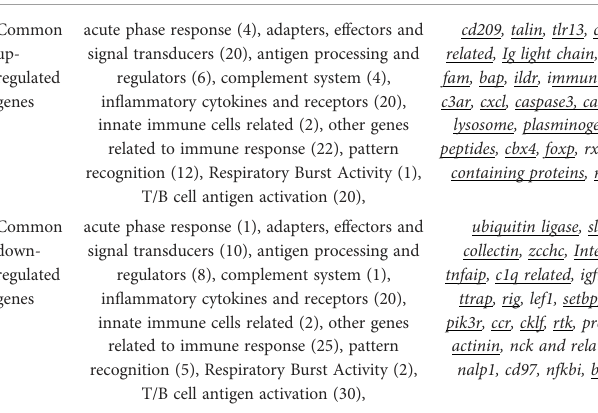
TABLE 3 The immune process and immune gene category for overlapping genes in the Venn diagram, DEGs with FC>2 is underlined. Immune process